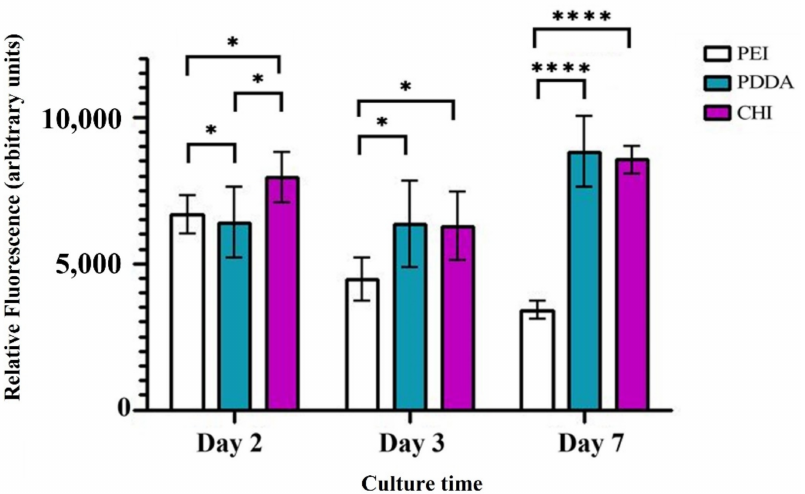
Figure 5. Resazurin reduction assay results as an indication of the U-2 OS cell viability upon exposure to the PEI, PDDA and CHI coatings on square glass cover slips, cultured under standard conditions for 2, 3 and 7 days. Each scaffold type was tested in triplicate. Any statistical significance is shown where p < 0.05. Increasing significance is represented by an increasing number of asterisks (* p < 0.05 and **** p <